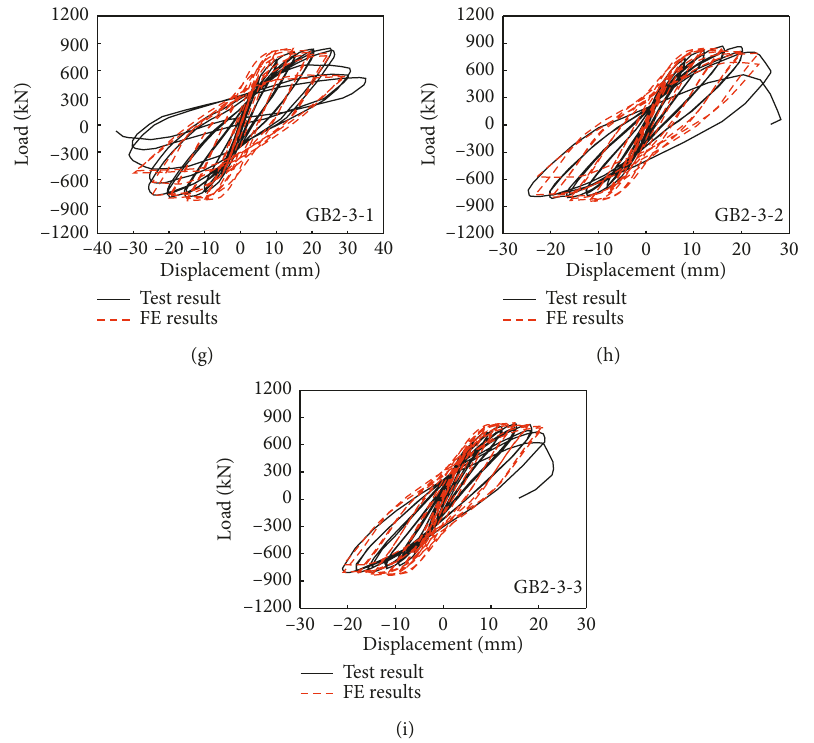
Figure 6: Comparison of displacement-force relation between tests and finite element results. (a) W1-a; (b) W1-b; (c) W1-c; (d) SPRCW1; (e) SPRCW2; (f) SPRCW3; (g) GB2-3-1; (h) GB2-3-2; (i) GB2-3-3. Table 2: Comparison of strengths between tests and finite element results.